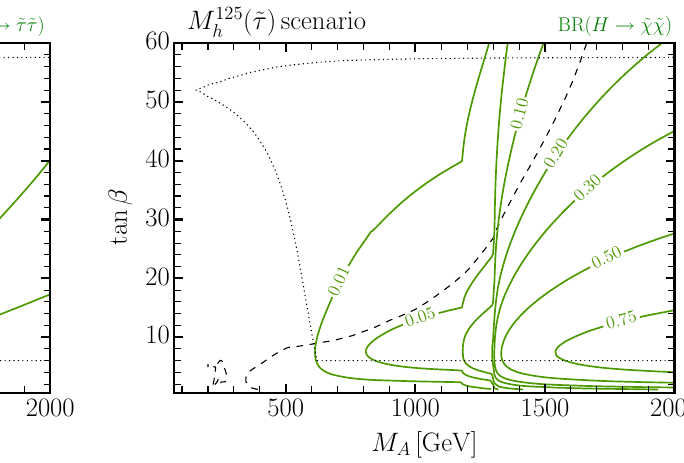
ratio of the decays of H into chargino or neutralino pairs. In each plot, the boundaries of the blue and the hatched exclusion regions of Fig.2 are also shown as a dashed and a dotted black line,